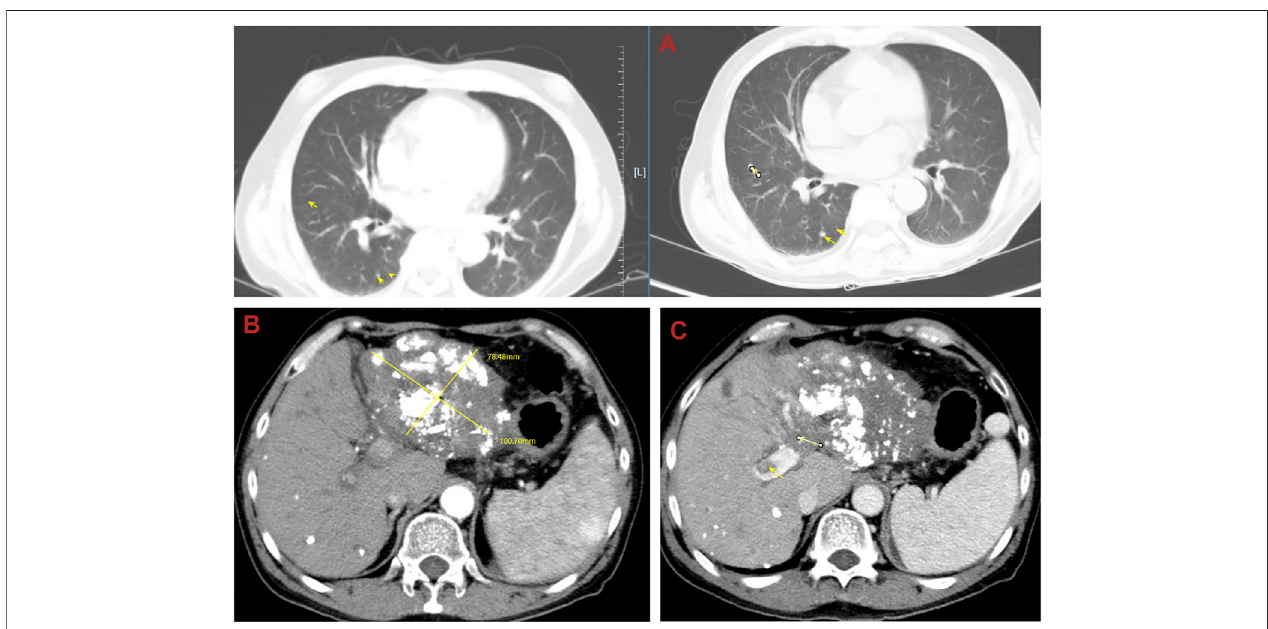
FIGURE 3 | Abdominal computed tomography (CT) shows that multiple small nodules in both lungs were signi fi cantly reduced and shrunken and the tumor in the liver was signi fi cantly reduced. (A) The lung metastases was reduced and shrunken; (B) the tumor in the left lobe of the liver shrunk; (C) the tumor thrombosis in the left portal vein.